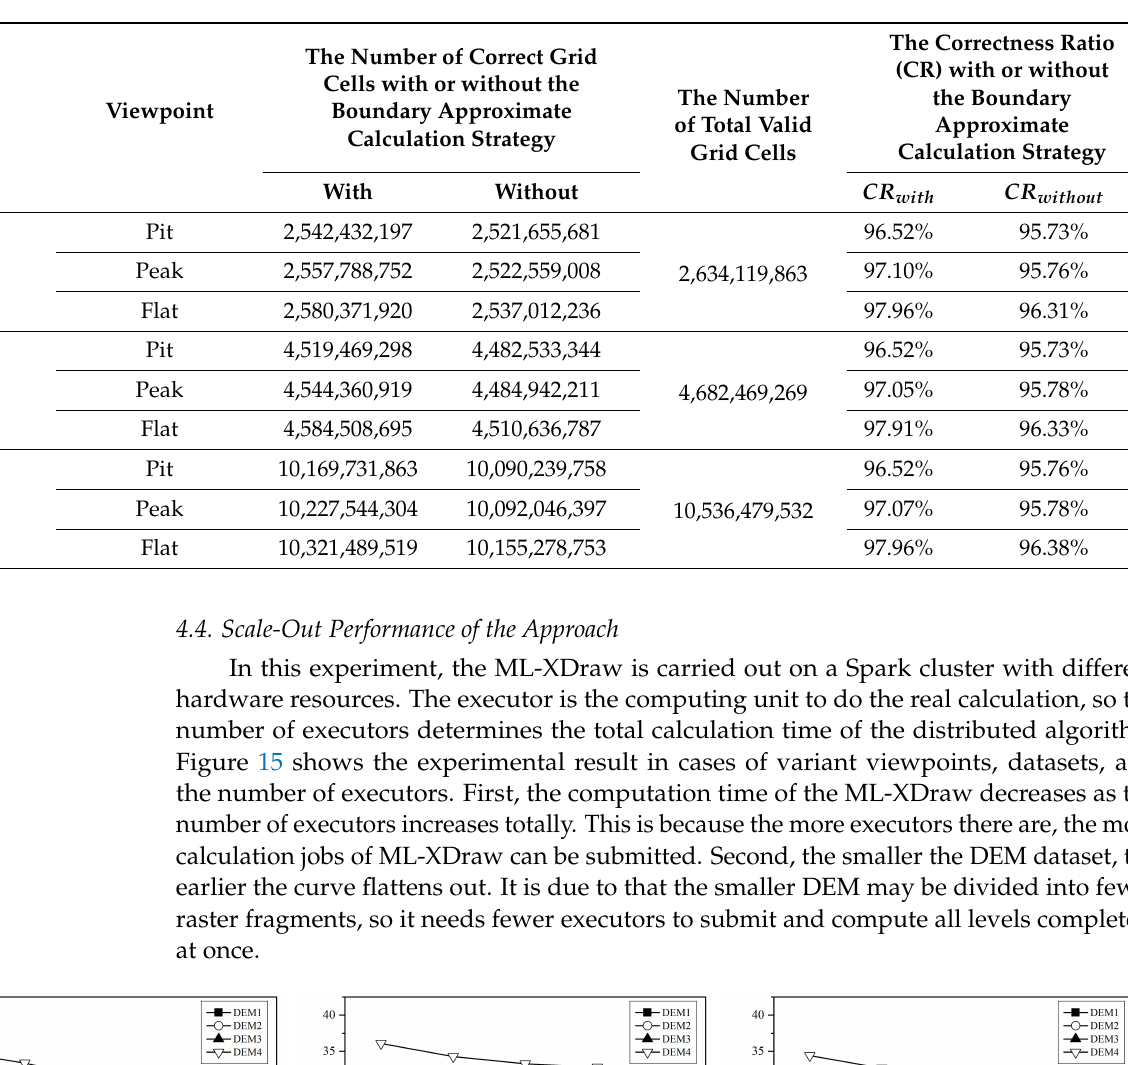
Table 4. Accuracy comparison of the ML-XDraw with the boundary approximate calculation strategy and without one.